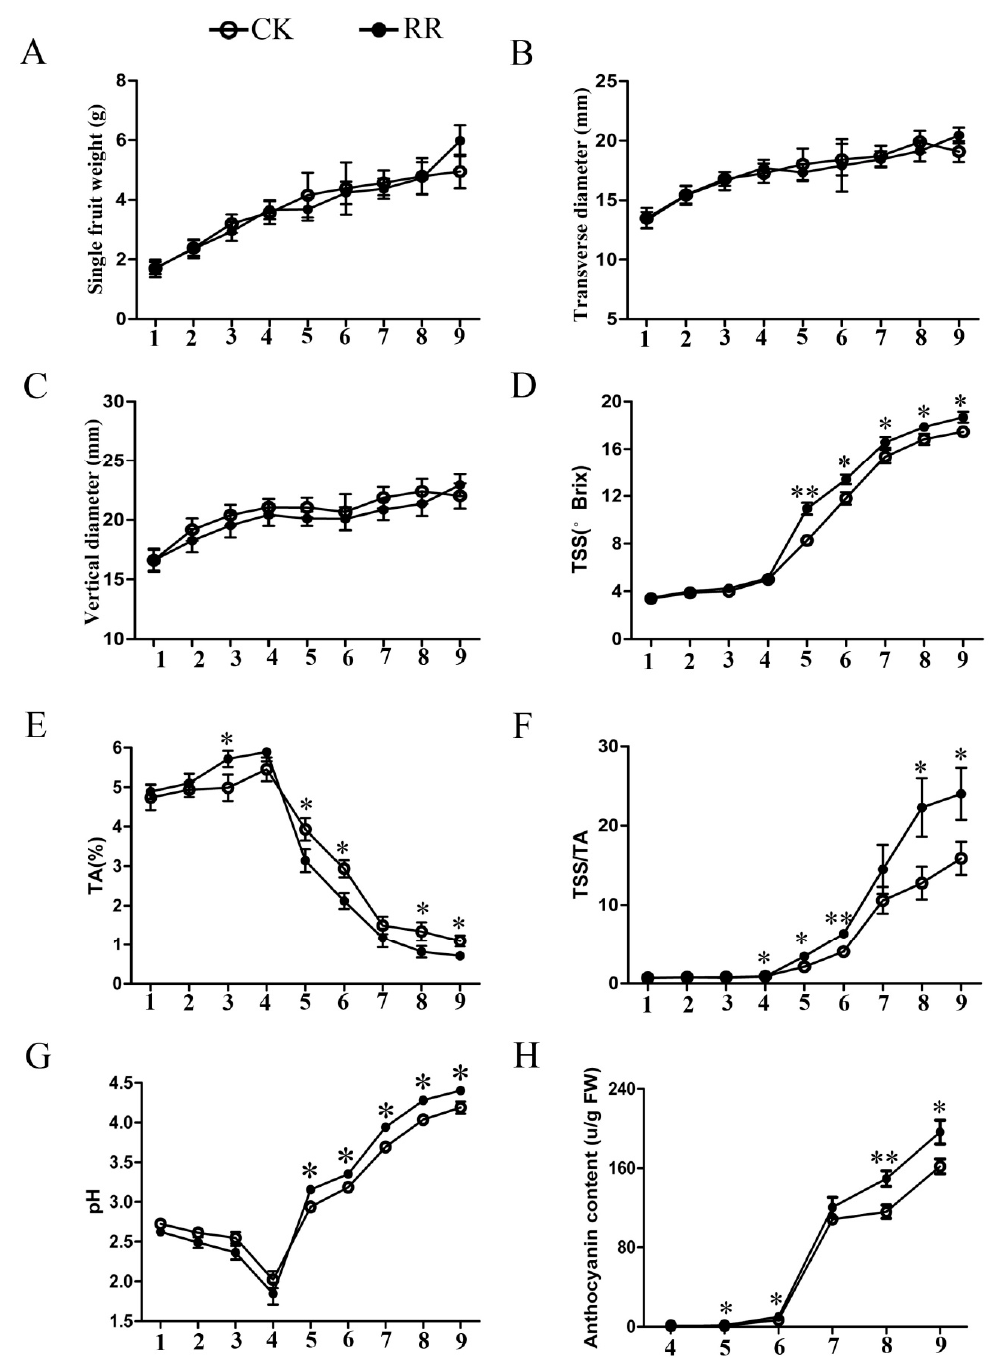
Figure 2. Dynamic changes of grape fruit size and contents in di ff erent growth stages. ( A ) Dynamic change of single fruit weight in di ff erent growth stages. ( B ) Dynamic change of fruit width in di ff erent growth stages. ( C ) Dynamic change of fruit vertical diameter in di ff erent growth stages. ( D ) Dynamic change of soluble solids in di ff erent growth stages. ( E ) Dynamic change of titratable acid (TA) content in di ff erent growth stages. ( F ) Dynamic change of total soluble solid / TA (TSS / TA) in di ff erent growth stages. ( G ) Dynamic change of pH in di ff erent growth stages. ( H ) Dynamic change of anthocyanin content in di ff erent growth stages. RR: Root restriction, CK: control group. 1–9 indicate that the sample collection time is 6 June, 14 June, 22 June, 4 July, 14 July, 18 July, 23 July, 1 August, and 9 August 2017, respectively. * p < 0.05 and ** p < 0.01 respectively according to two-tailed Student’s t -test. Error bars show the standard error between three biological replicates ( n =3).